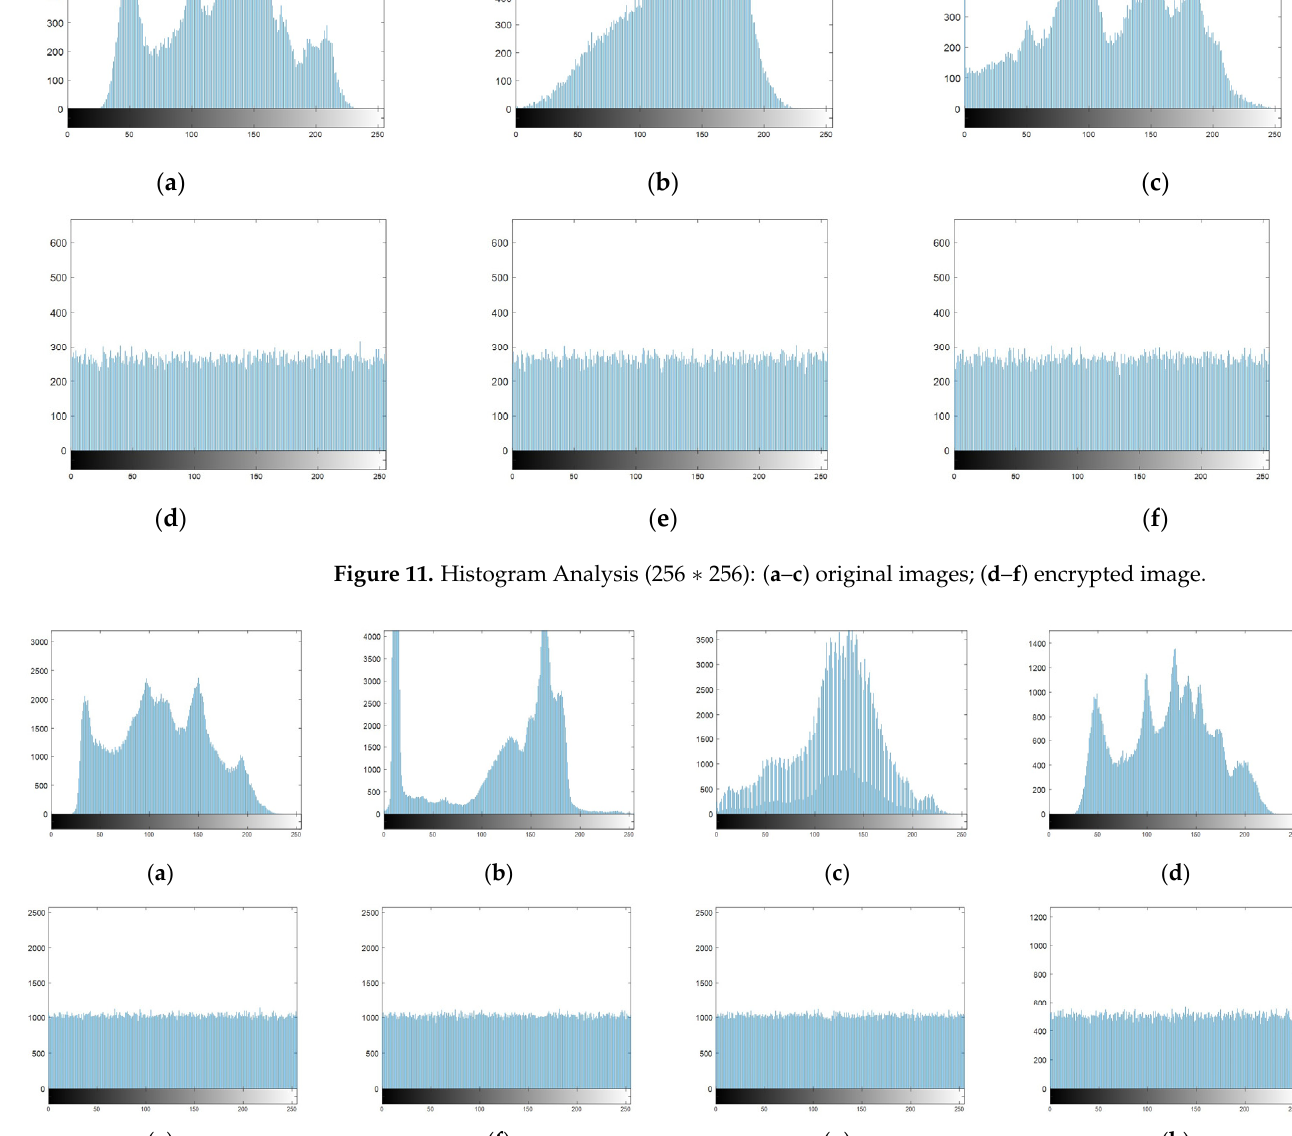
Figure 12. Histogram Analysis (512 ∗ 512 and irregular): ( a – d ) original images; ( e – h ) encrypted image.